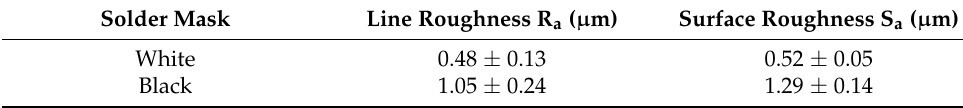
Table 1. Results of roughness measurement of the solder